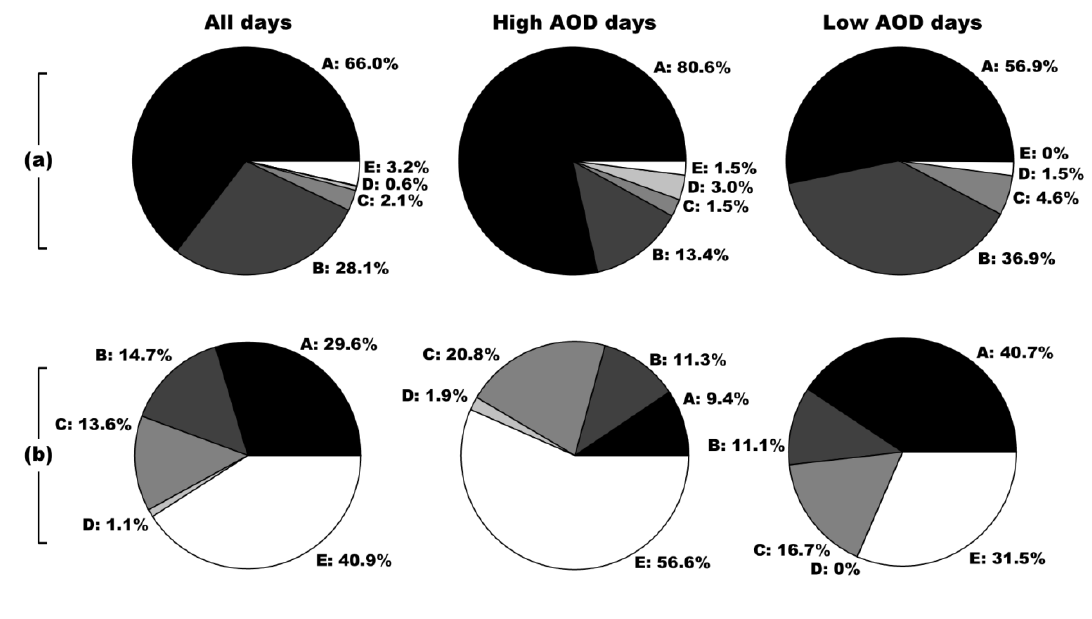
Figure 8. Air mass source origin for all days, high AOD days (>90th percentile) and low AOD days (<10th percentile) for ( a ) spring upper air trajectories (ending altitude of 3000 m AGL) and ( b ) winter low level (500 m AGL) trajectories. High and low AOD days were identified using the consolidated MODIS Deep Blue (Terra and Aqua) and MISR AOD